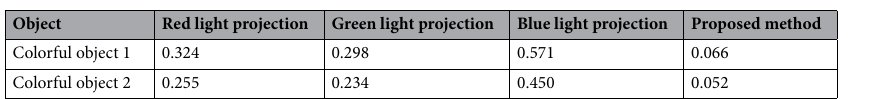
Table 5. Quantitative comparisons of colorful objects